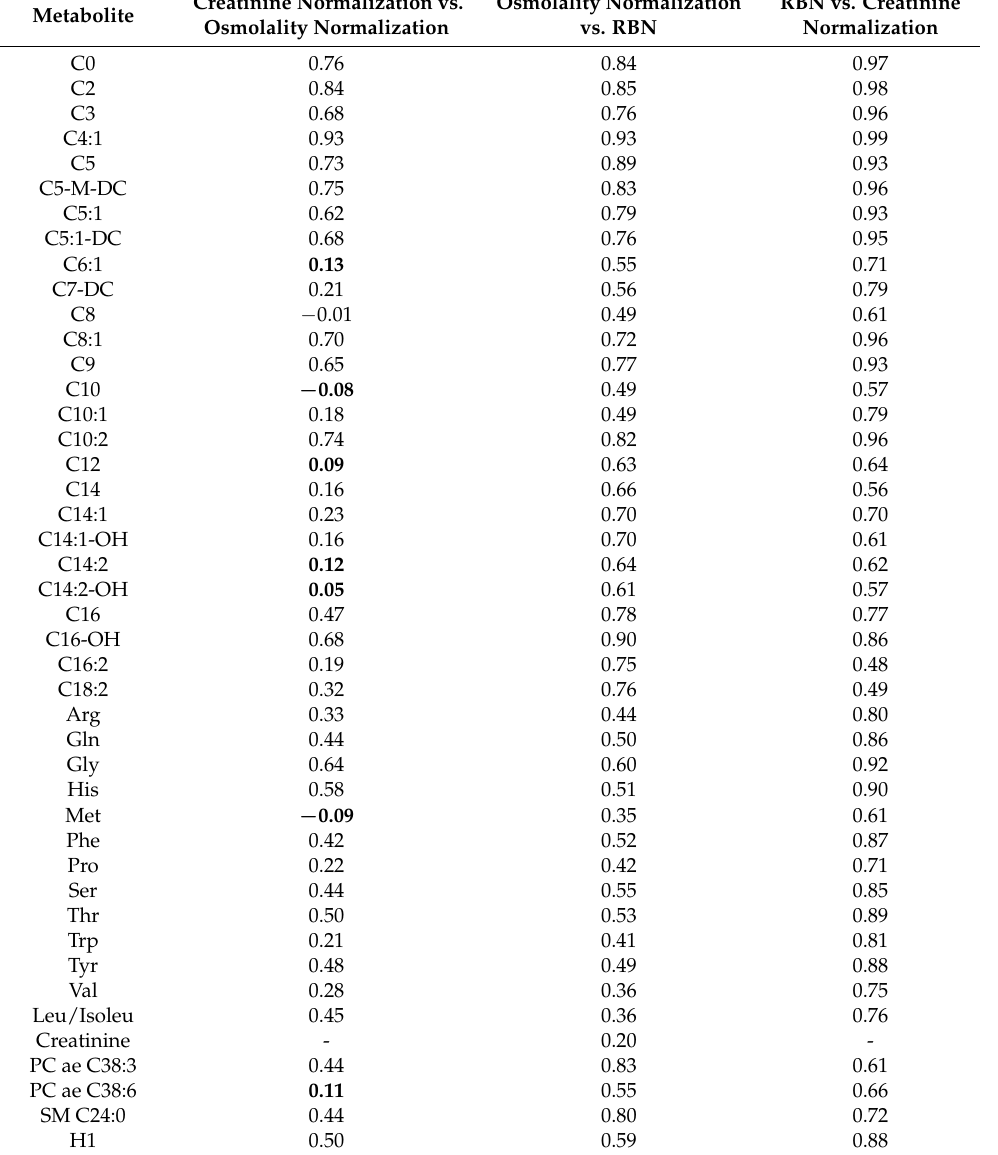
Table 2. Correlation of 44 metabolites concentrations after creatinine-, osmolality- and regression-based normalization. Pearson correlation coefficients of three pairwise comparisons are shown. Non-significant correlations are indicated in bold (Bonferroni cut off; p -values < 1.14 × 10 − 3 ). In summary, absolute correlation coefficients > 0.15 reflect a statistical